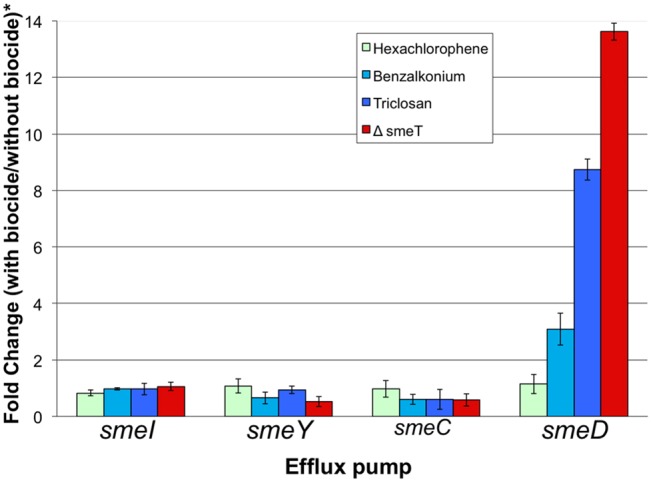
Effect of biocides on the expression of S. maltophilia efflux pumps.The amount of mRNA of efflux pumps in the presence of biocides was measured by real time RT-PCR. Fold changes were estimated with respect to the value determined for the wild type strain grown in the absence of any biocide. *In the strain D457R, expression of smeDEF is fully derepressed, in the absence of the biocide, due to a mutation that inactivates SmeT. As shown, benzalkonium chloride can induce expression of smeD, although the level reached is lower than in the D457R mutant, whereas the expression of the other analyzed efflux pumps is not induced by the biocide.